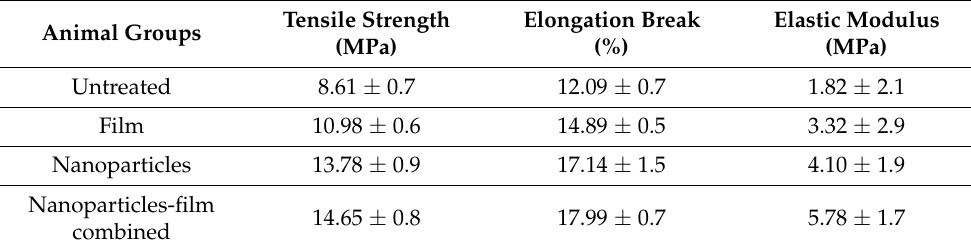
Figure 9. Thermograms of ( a )untreated, ( b ) film treated, ( c ) nanoparticles treated, and ( d ) film-nanoparticles combined treated skin samples. Table 5. Mechanical properties of skin sample.